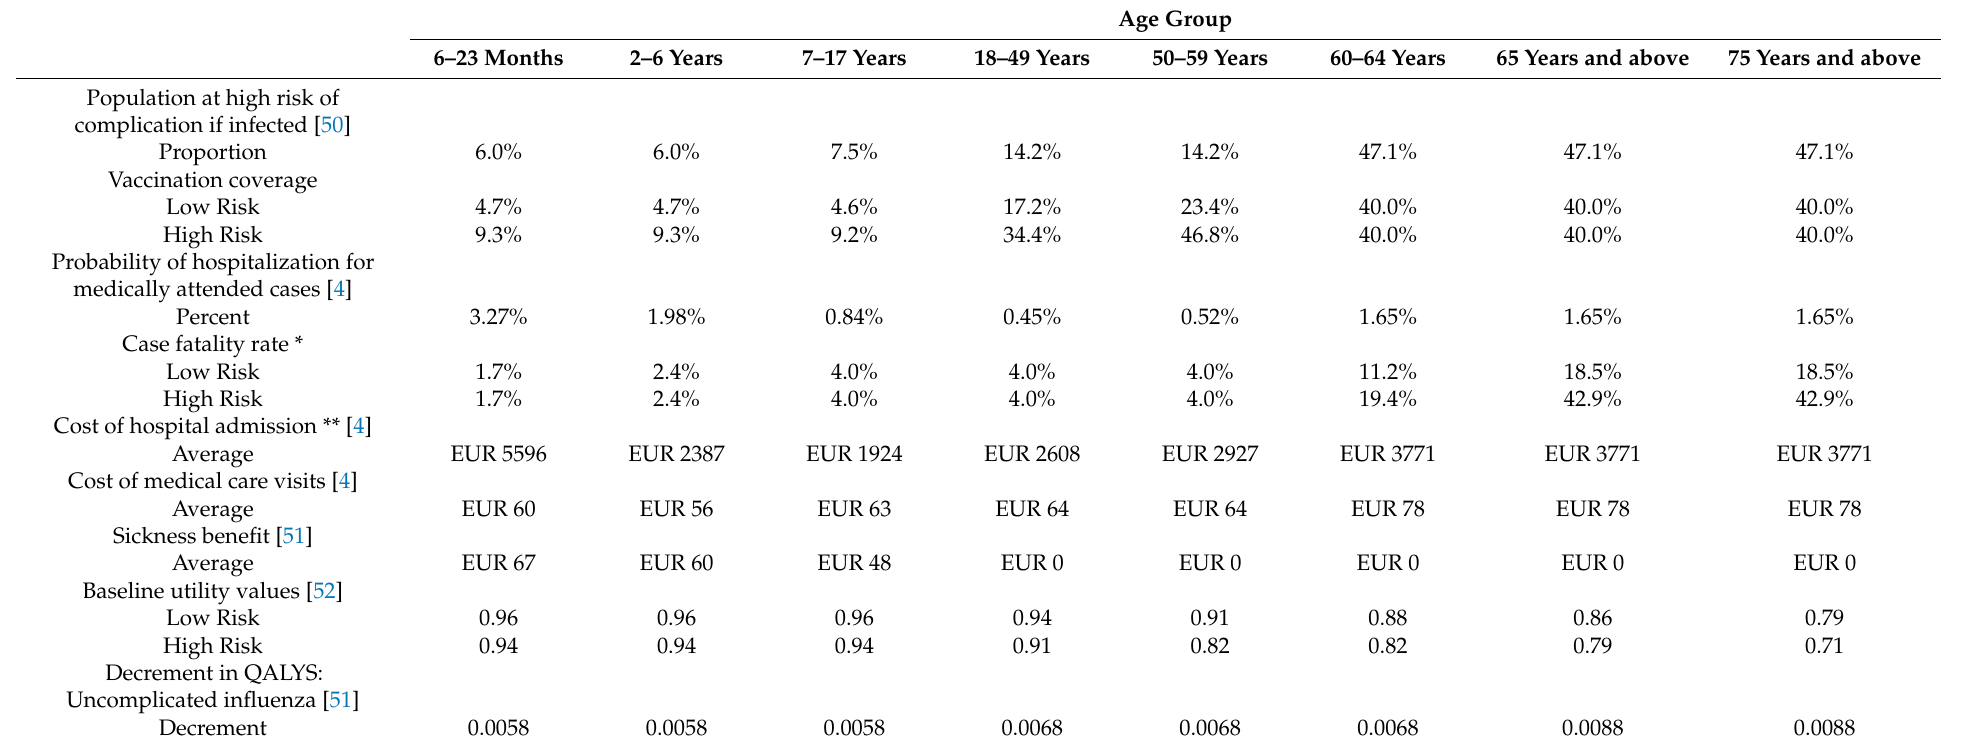
Table 2. Additional inputs for the base case